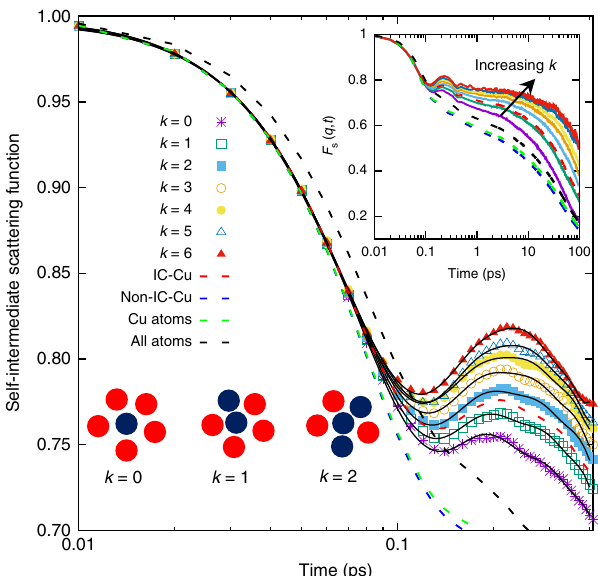
Fig. 1 Relaxation dynamics of the system at short times. Short-time behavior of the self-intermediate scattering function of particles with different local connectivity k (symbols). The wave-vector is q = 2.8 Å − 1 and T = 1000 K. With increasing k the height of the peak at around 0.2 ps increases showing that the motion becomes less damped. The solid lines are fi ts to the data with Eq. (2). Also included is F s ( q , t ) for the Cu atoms in an icosahedral cluster (dashed red line), the Cu atoms not in an icosahedral cluster (blue dashed line), and all Cu atoms (green). The black dashed line is the correlation function averaged over all atoms. The upper inset shows the same data in a larger time interval. The lower inset illustrates the de fi nition of particles with different connectivities k : Particles in blue are the center of an icosahedral-like